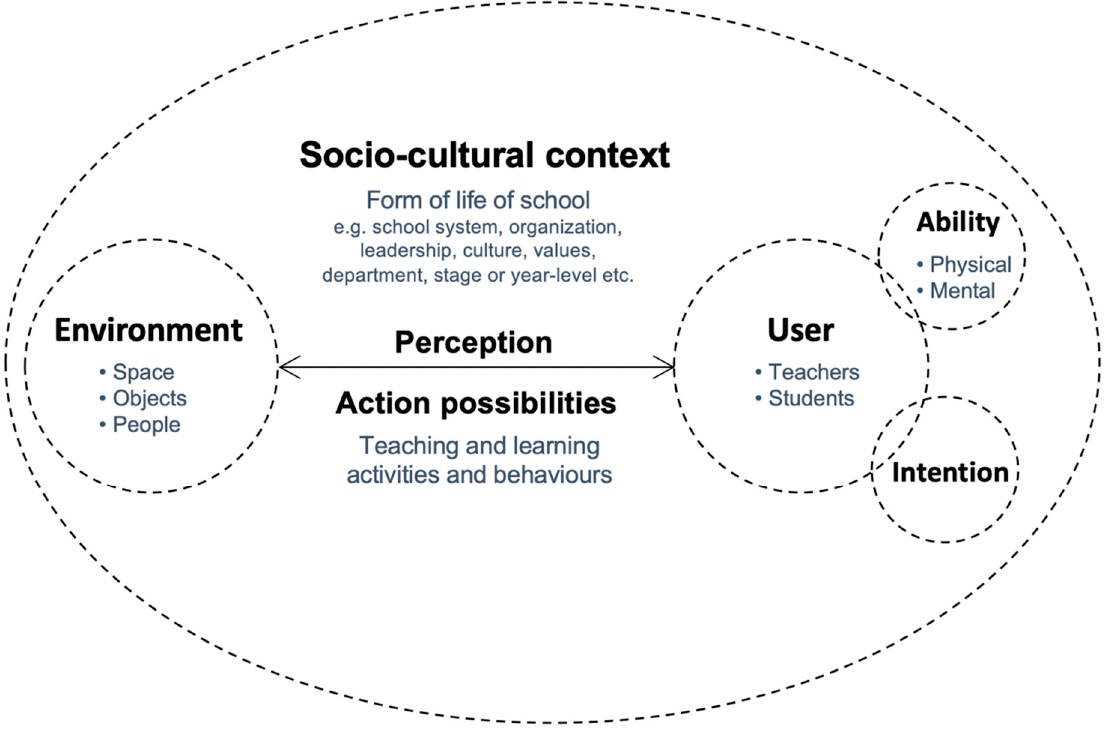
Figure 6. Learning environment affordance framework [42].